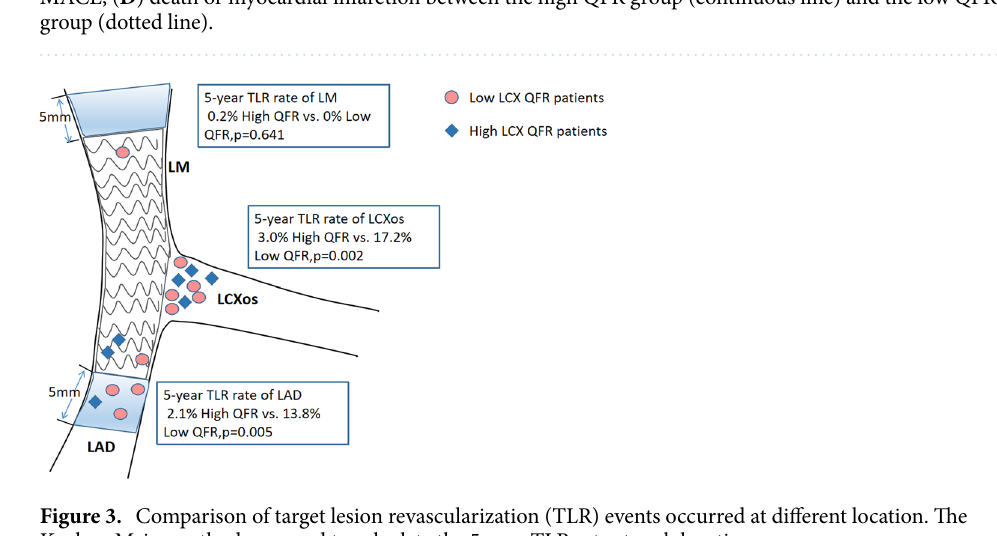
Figure 3. Comparison of target lesion revascularization (TLR) events occurred at different location. The Kaplan–Meier method was used to calculate the 5-year TLR rate at each